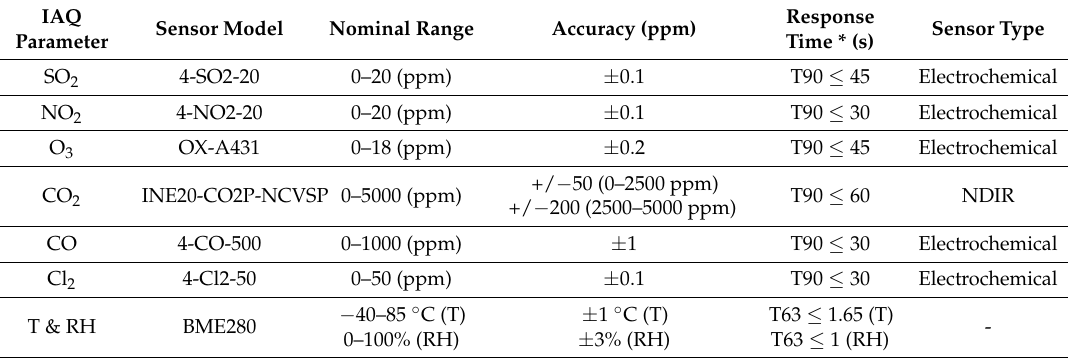
Table 1. Specifications of the sensors used.